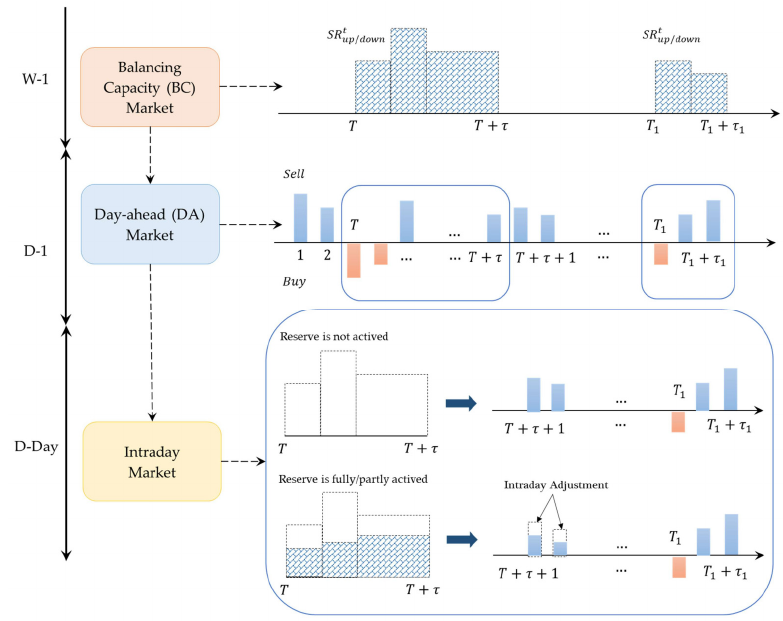
Figure 2. The VPP scheduling strategy in BC, DA, and ID markets.